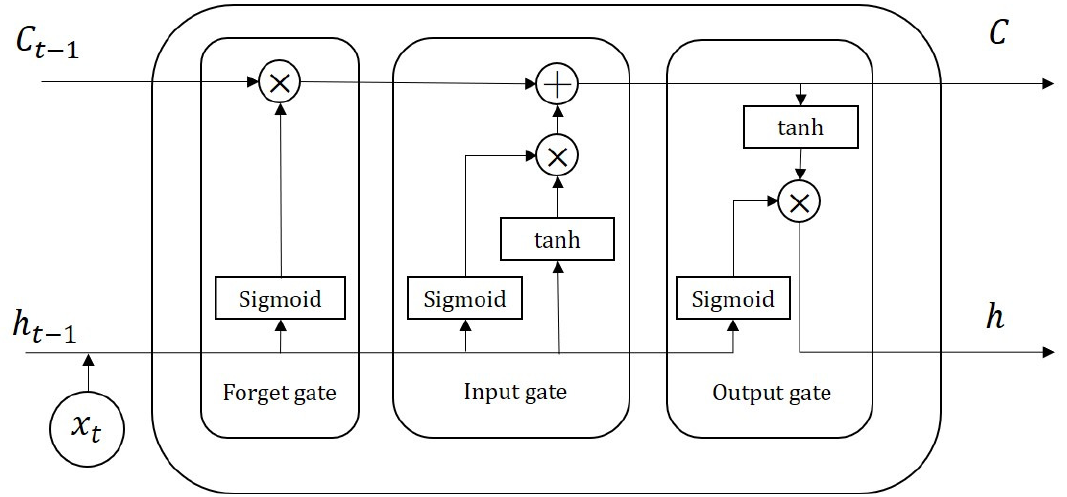
Figure 5. Architecture of a LSTM unit.